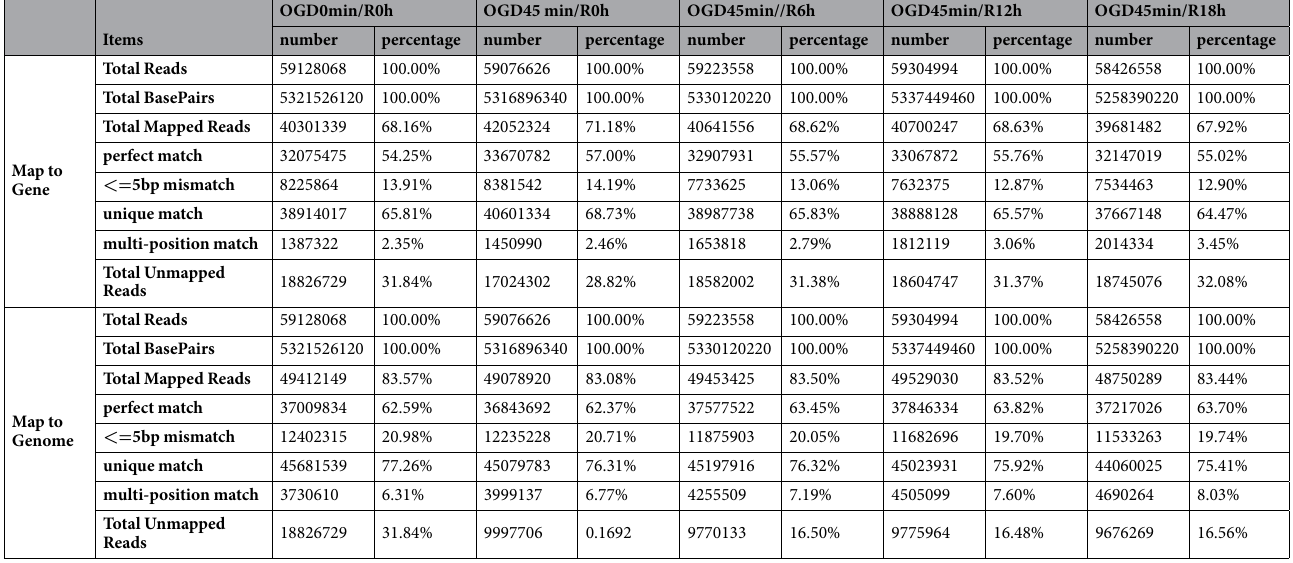
Table 1. Sequencing statistics of individual